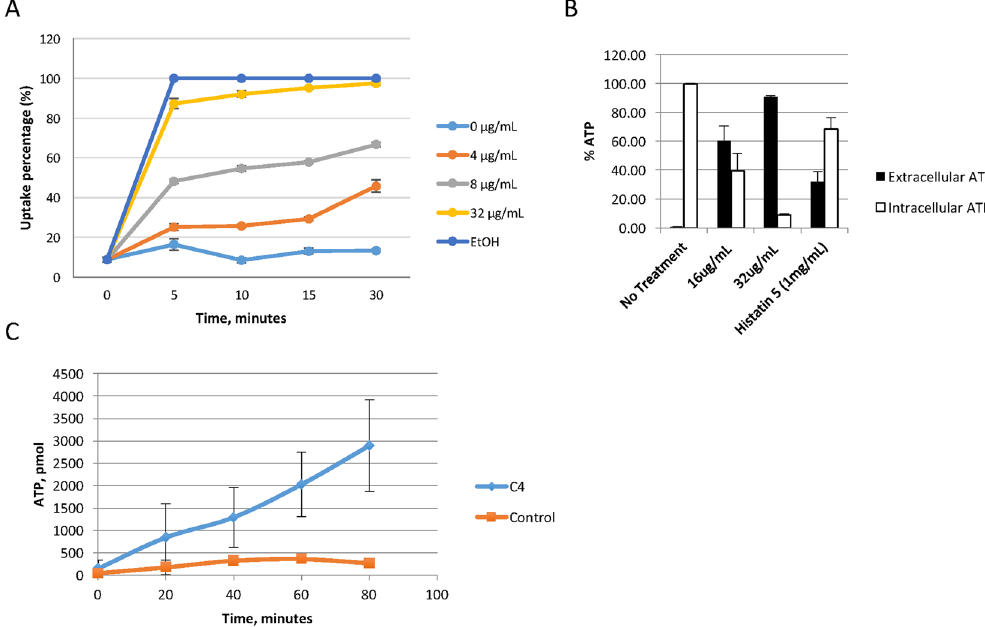
Figure 2. Membrane permeabilization assays. ( A ) Propidium iodide incorporation. Planktonic C. albicans (3.4 × 10 6 cfu/ml) were treated with C4 at the indicated concentrations for increasing time. At each point samples were stained with PI, and incorporation was quantified by flow cytometry. 100% ethanol was used as a positive control. Shown are mean percent intracellular fluorescence of triplicate samples. Error bars indicate standard deviation. ( B ) ATP efflux in planktonic cells. C. albicans blastoconidia (approx. 1 × 10 7 cfu/ml) were treated with C4 or histatin followed by quantification of intracellular and extracellular ATP. Error bars indicate standard deviation. Extracellular ATP in all treated samples was significantly greater than untreated (p < 0.01) by t-test. ( C ) ATP efflux in biofilms. C. albicans biofilms (n = 3) with approx. 1 × 10 7 cfu were treated with 100 µ g/ml C4, and extracellular ATP was quantified over time. Shown are mean extracullular ATP concentration + / − standard